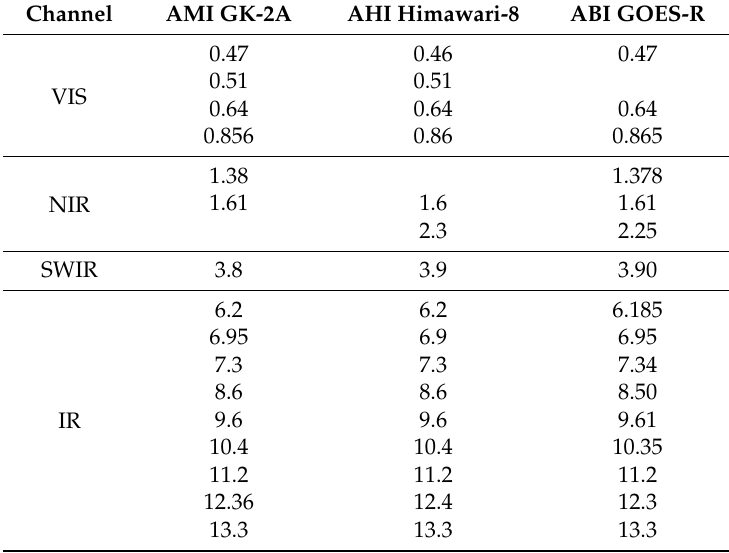
Table 1. Comparison of central wavelength of next generation geostationary